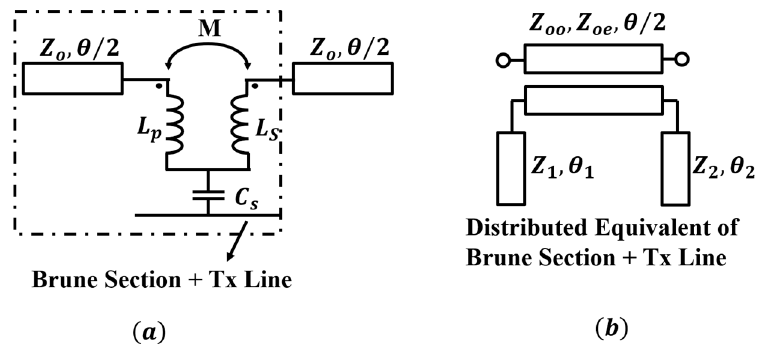
Figure 7. ( a ) K-Inverter equivalent circuit with Coupled Inductor Brune Section. ( b ) Distributed realization of the cascade connection of the Transmission Line element and the Coupled Inductor Brune element.